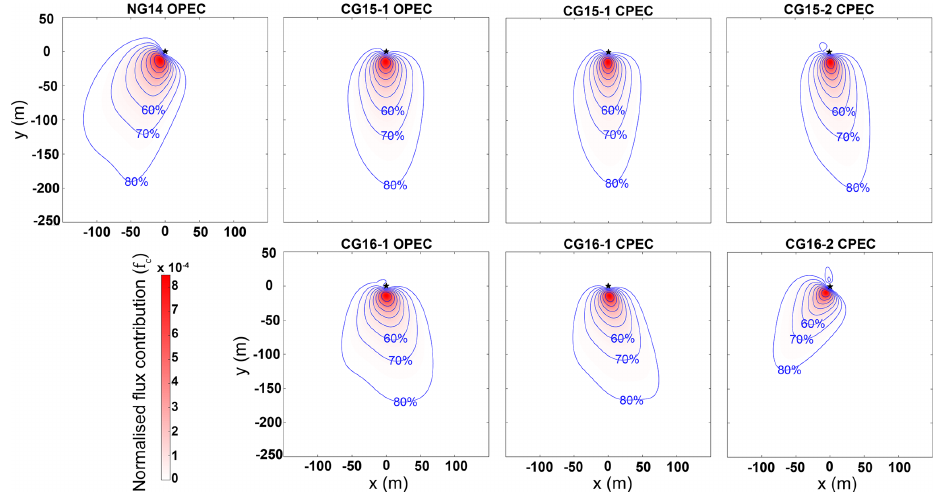
Figure 9. Flux footprint maps for each EC system deployed during the study, including percentage of crosswind integrated flux contribution (purple contours). Distances are in metres east ( x ) and north ( y ) of the AWS (black star). Maps were produced following the methods of Kljun et al. (2015). Table 5. Momentum roughness length values (in millimetres) for each station estimated using remote methods ( z 0v_bloc and z 0v_prof ) from the lidar-derived DEMs. The roughness values for the prevailing downslope southerly wind direction are shown here. f c_100 represents values for an assumed 101 × 101m upwind footprint, where F D_local values are given equal weighting. The uncertainty values from error propagation are shown for z 0v_bloc , while for z 0v_prof , ± σ of the roughness values for the 101 × 101m upwind patch is presented. NG14 CG15-1 CG15-2 CG16-1 CG16-2 z